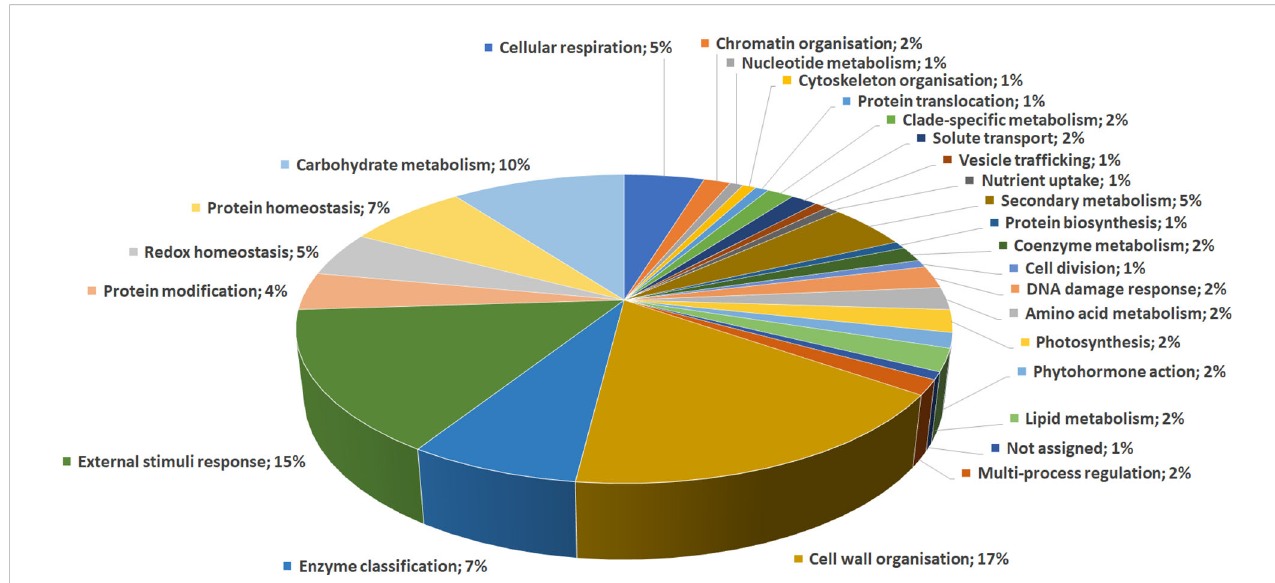
FIGURE 3 Functional distribution of differentially represented proteins in persimmon fruits of Kaki tipo, Cioccolatino, Vaniglia and Lampadina cultivars. Identi fi ed protein species were initially assigned with Mercator software, followed by a functional group cataloguing including information from recent literature